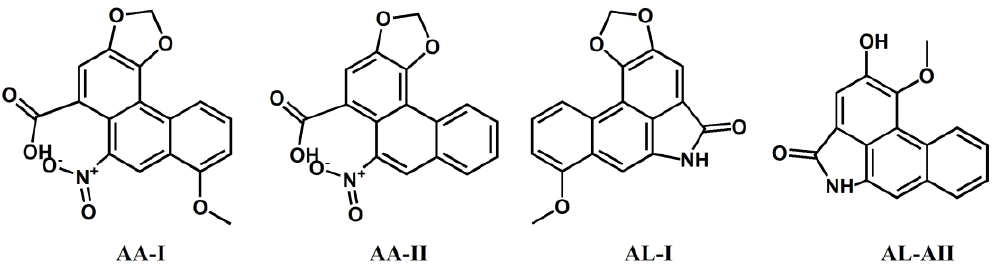
Figure 1. Molecular structures of aristolochic acids and their analogues.